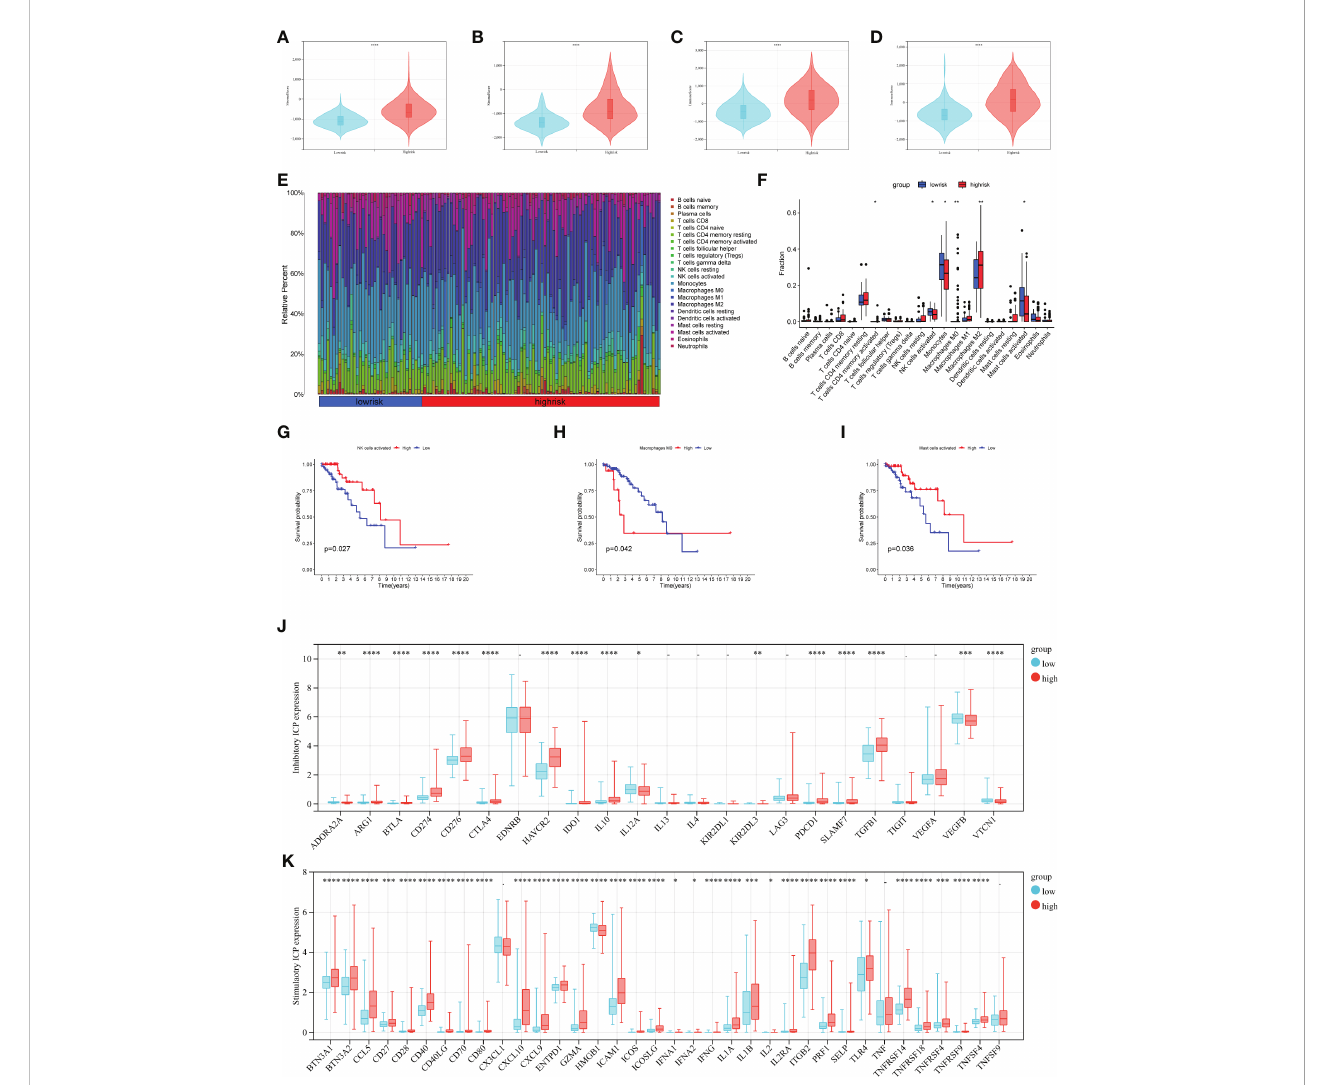
FIGURE 6 Analysis of immune in fi ltration in different risk groups. (A – D) Immune score and stromal score calculated by ESTIMATE in different groups (A, C TCGA data set, and B, D CGGA data set ) . (E, F) The relative in fi ltrating proportion of 22 immune cells in high- and low-risk groups. (G – I) KM curves of in fi ltrating immune cells associated with survival in LGGs patients (p< 0.05). (J, K) Immune checkpoints expression in the LGGs microenvironment, inhibitory ICP (J) , and stimulatory ICP (K) . (*p < 0.05, **p <0.01, ***p <0.001, ****p